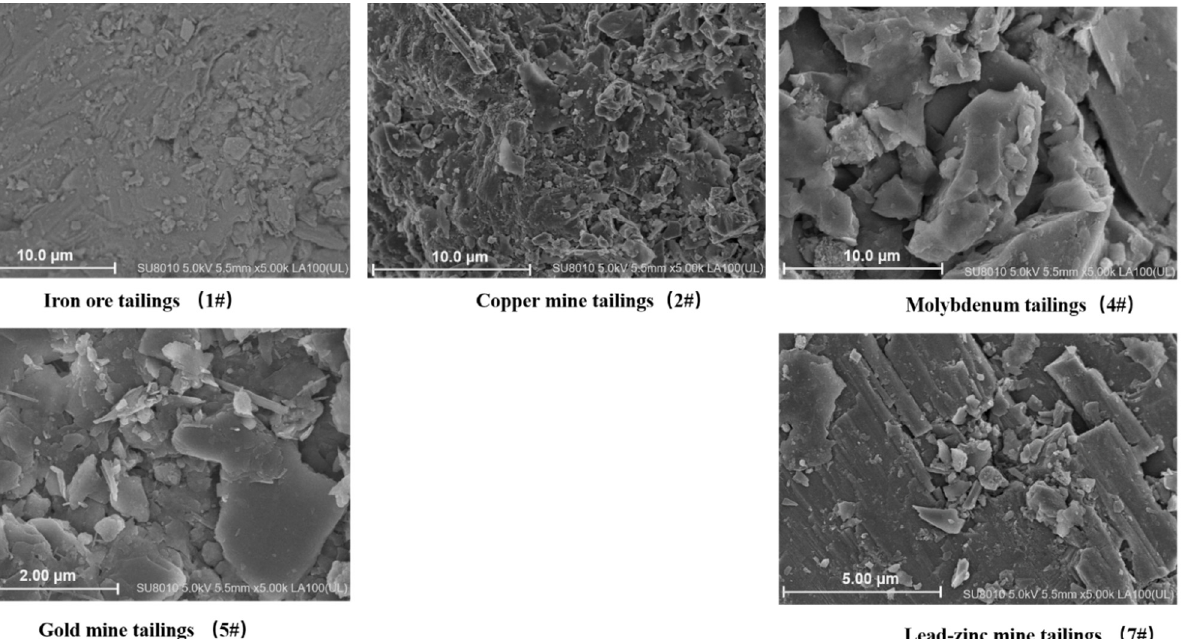
(Table 4). The content of SiO 2 ranged from 33.07% to 91.41%, with the biggest difference. The contents of Al 2 O 3 , Fe 2 O 3 and CaO in different types of tailings were 2.72%–15.88%,